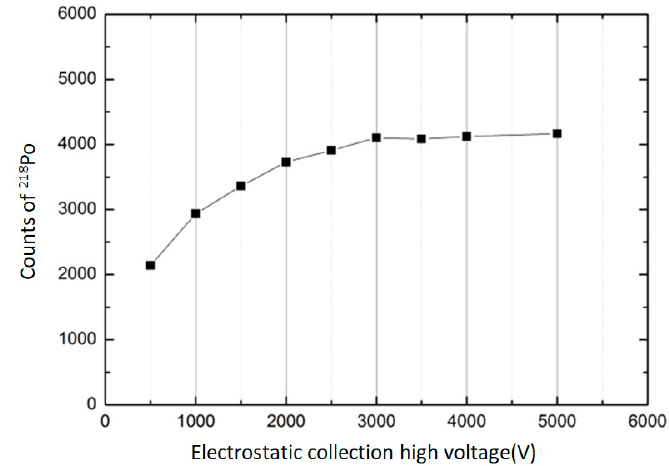
Figure 3. Relationship between 218 Po counts and the electrostatic-collecting high voltage.